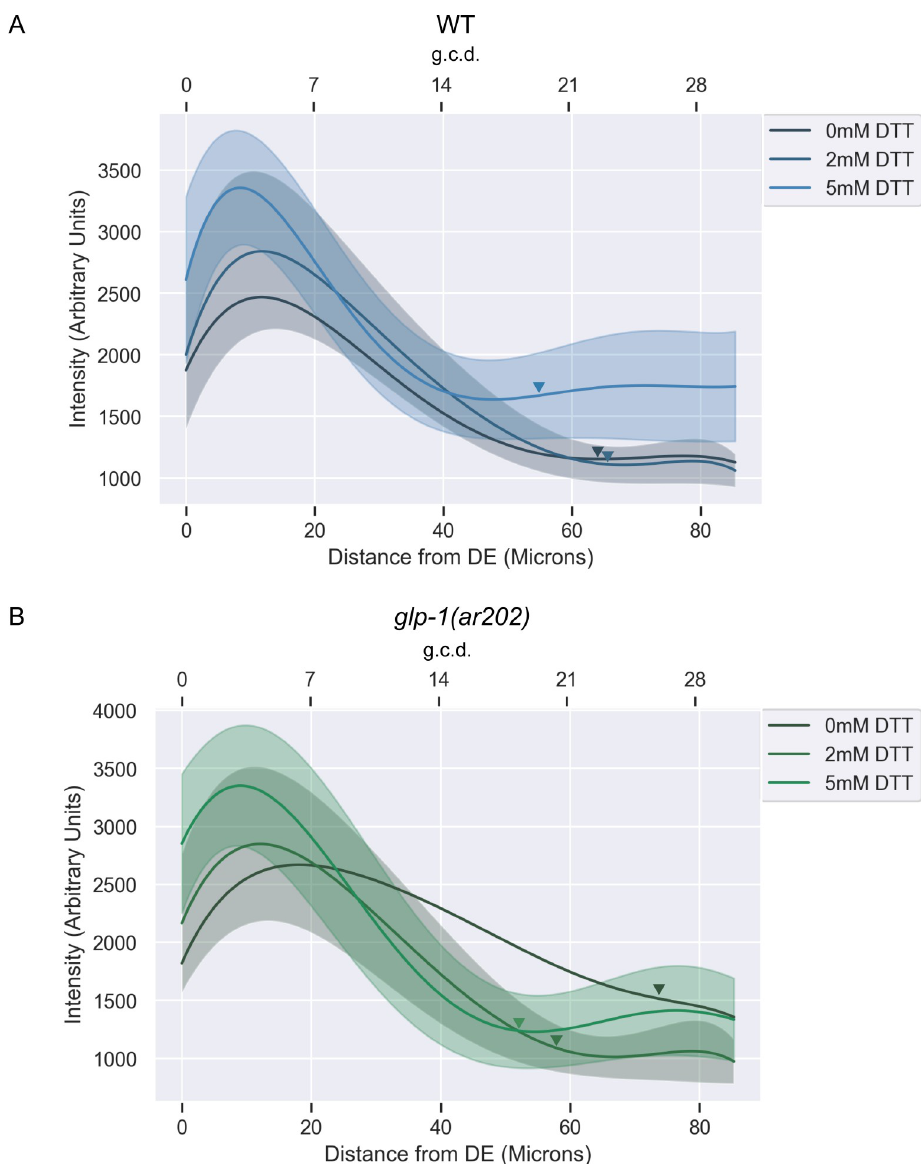
Fig 8. Chemical induction of ER stress by DTT reduces the spread of SYGL-1, a readout for GLP-1/Notch signalling in glp-1(ar202) germlines. A. Normalized, fitted average SYGL-1 intensities of otherwise wild type gonads harbouring the sygl-1(am307) allele grown on DTT. Shaded areas indicate unscaled fitted standard deviation of the intensity measurements for each genotype. Standard deviation for average 0 mM DTT treatment has not been shown for ease of visualization but can be seen in S6 Fig. Average normalized intensities and standard deviations were fit to a sixth order polynomial. Fifteen gonads were analyzed for intensity measurements. Arrowheads point to the average location of the transition zone measured in at least seven gonads of each genotype. Distances from distal end (DE) were measured in microns and converted to germ cell diameters (g.c.d) as a reference, by assuming 1 g.c.d. = 2.833 microns. B. As in (A) but including the glp-1(ar202)